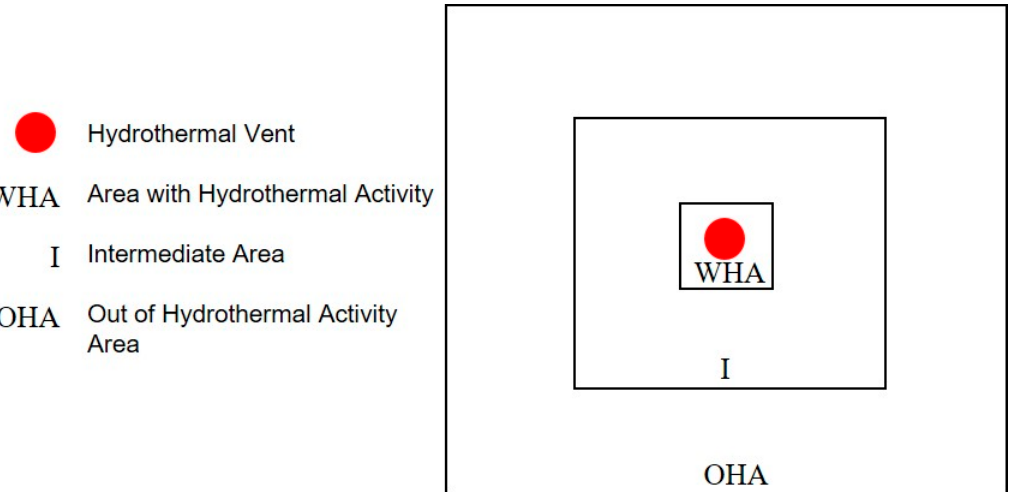
Figure 2. Diagram of the three areas in which each study site was stratified. WHA, area with hydrothermal activity; I, intermediate area; OHA, out of hydrothermal activity area. The red circle indicates the hydrothermal vent.